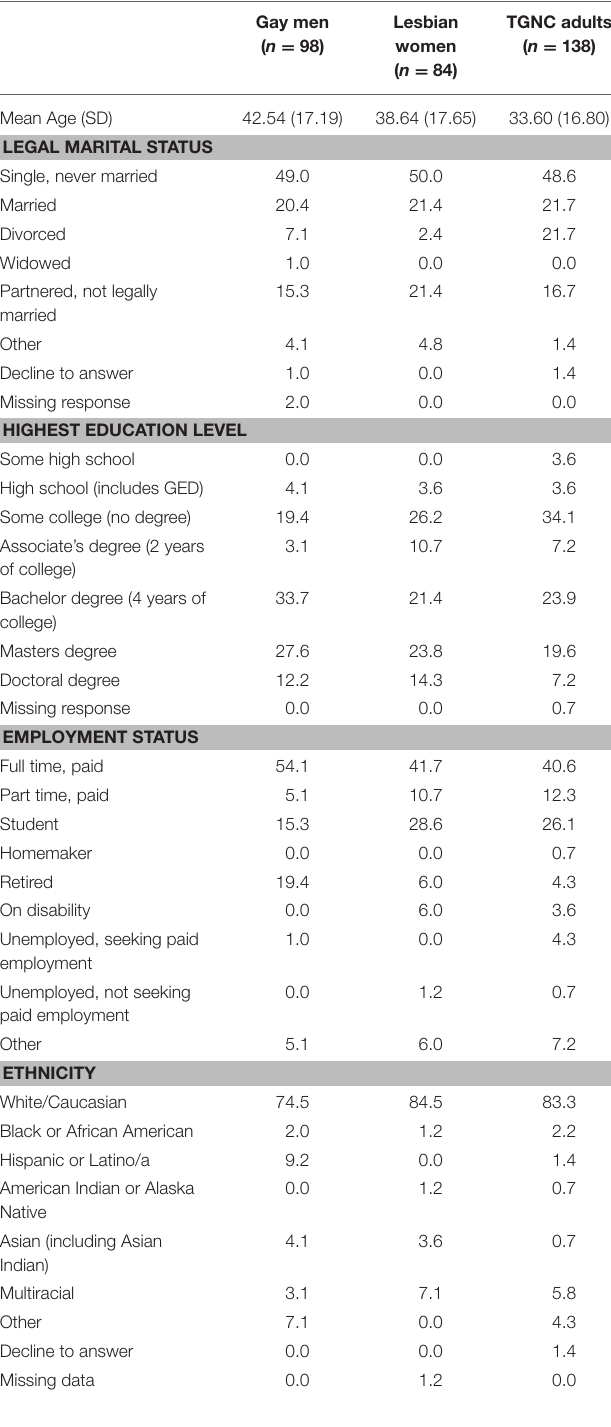
TABLE 1 | Participant demographic characteristics in